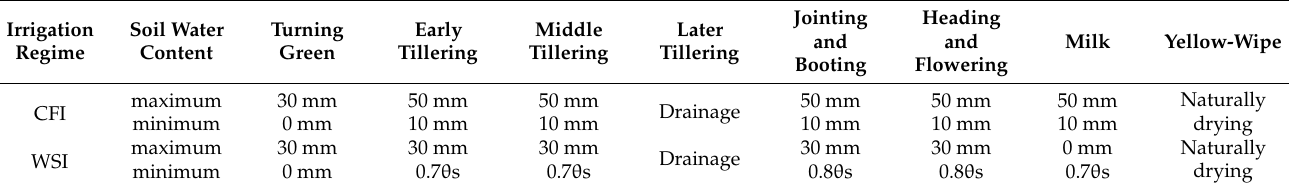
Table 1. Different water management patterns at the rice growth